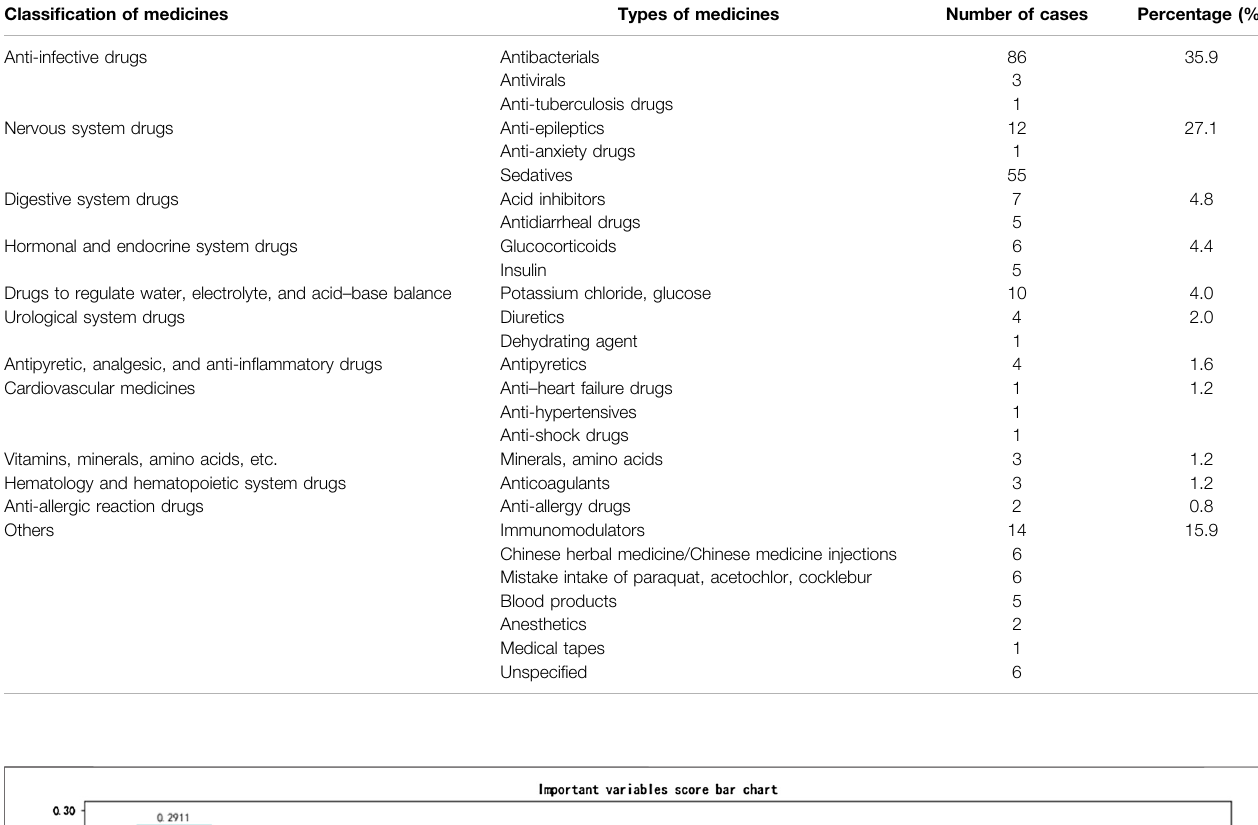
TABLE 2 | Classi fi cation of drugs leading to occurrence of ADEs.